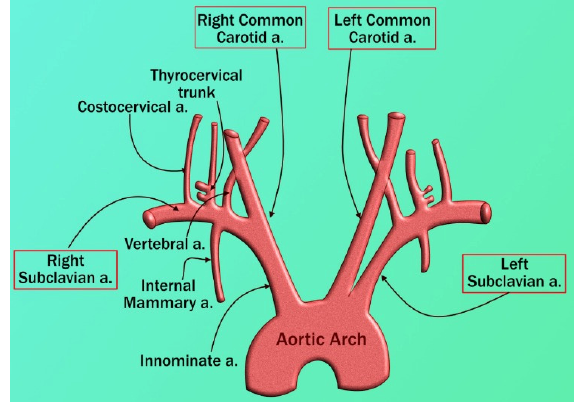
Figure 21. The inception of the left and right carotid arteries